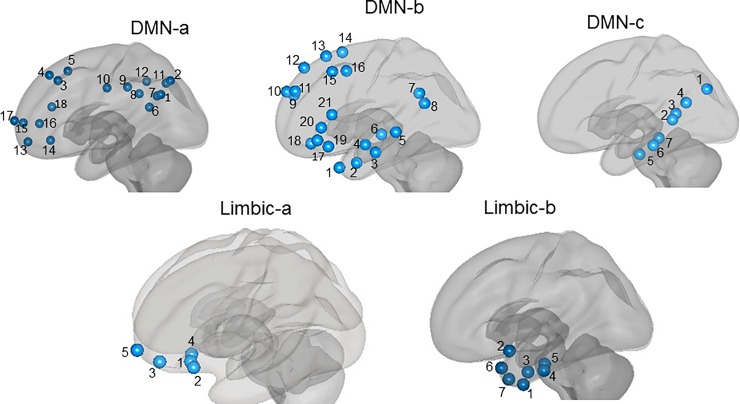
The three parcellations of the DMN and two parcellations of the limbic networks as delineated by the Schaefer et al., 2018 atlas [80].DMN-a: 1–2) inferior parietal lobule 1&2, 3–5) dorsal prefrontal cortex 1–3, 6–12) posterior cingulate cortex 1–7, 13–18) medial prefrontal cortex 1–6. DMN-b: 1–6) temporal cortex 1–6, 7–8) inferior parietal lobule 1&2, 9–14) dorsal prefrontal cortex 1–6, 15–16) left prefrontal cortex 1&2, 17–21) ventral prefrontal cortex 1–5. DMN-C: 1) inferior parietal lobule 1, 2–4) retrosplenial cortex 1–3, 5–7) parahippocampal cortex 1–3. Limbic a: 1–5) orbitofrontal cortex 1–5. Limbic-b: 1–7) temporal pole 1–7.